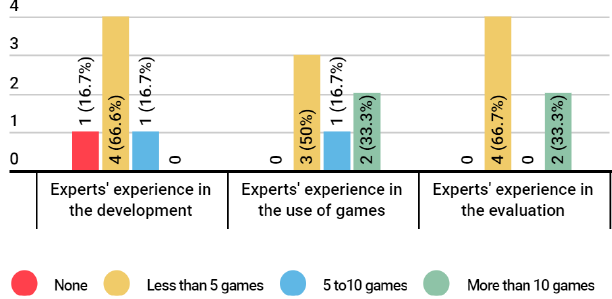
Figure 6. Experts’ experience in the development, use and evaluation of serious games.